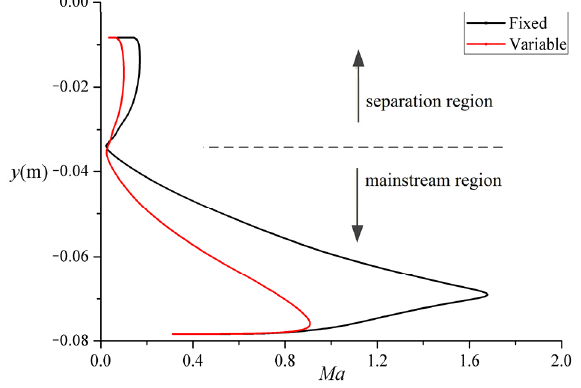
Figure 9. Comparison of the Mach number at inlet exit ( P out / P ∞ = 23).